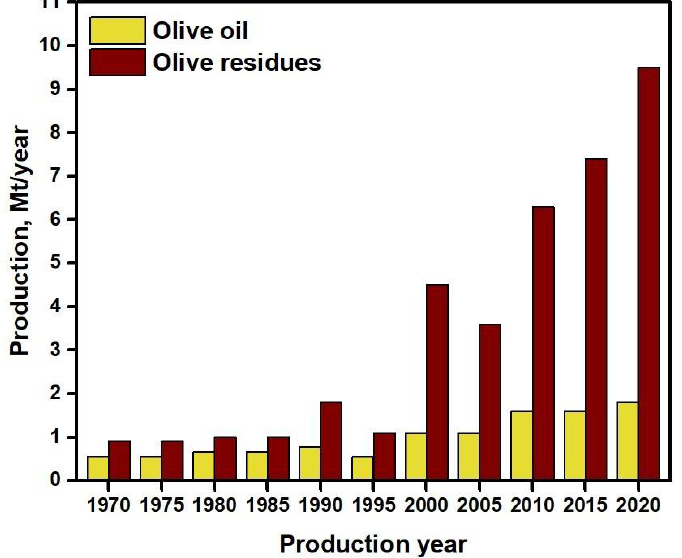
Figure 2. Annual production of olive oil and olive residues in Spain in the last 50 years.